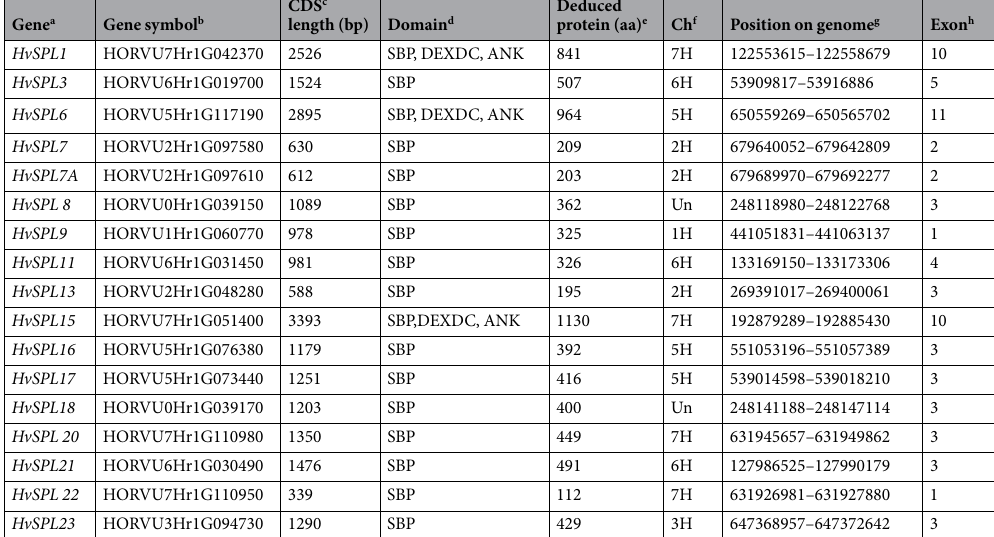
Table 1. Characteristics of identified SPL genes in H. vulgare . a Name referred to H. vulgare SPLs in this work. b Gene accession number in database. c Length of coding DNA sequence. d Domain predicted by SMART tool. e Length (number of amino acids). f Chromosome position of the HvSPL genes. g Location of HvSPL genes on barley genome. h Exon number in HvSPL